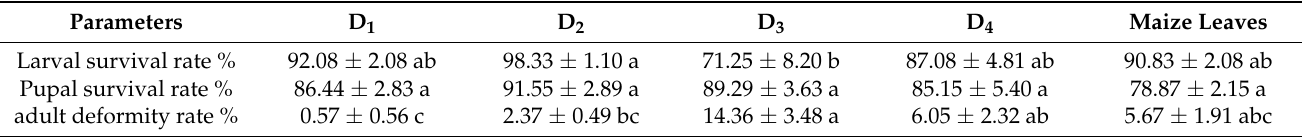
Table 3. Larval and pupal survival rate and adult deformity rate of FAWs ( Spodoptera frugiperda ) fed different diets.